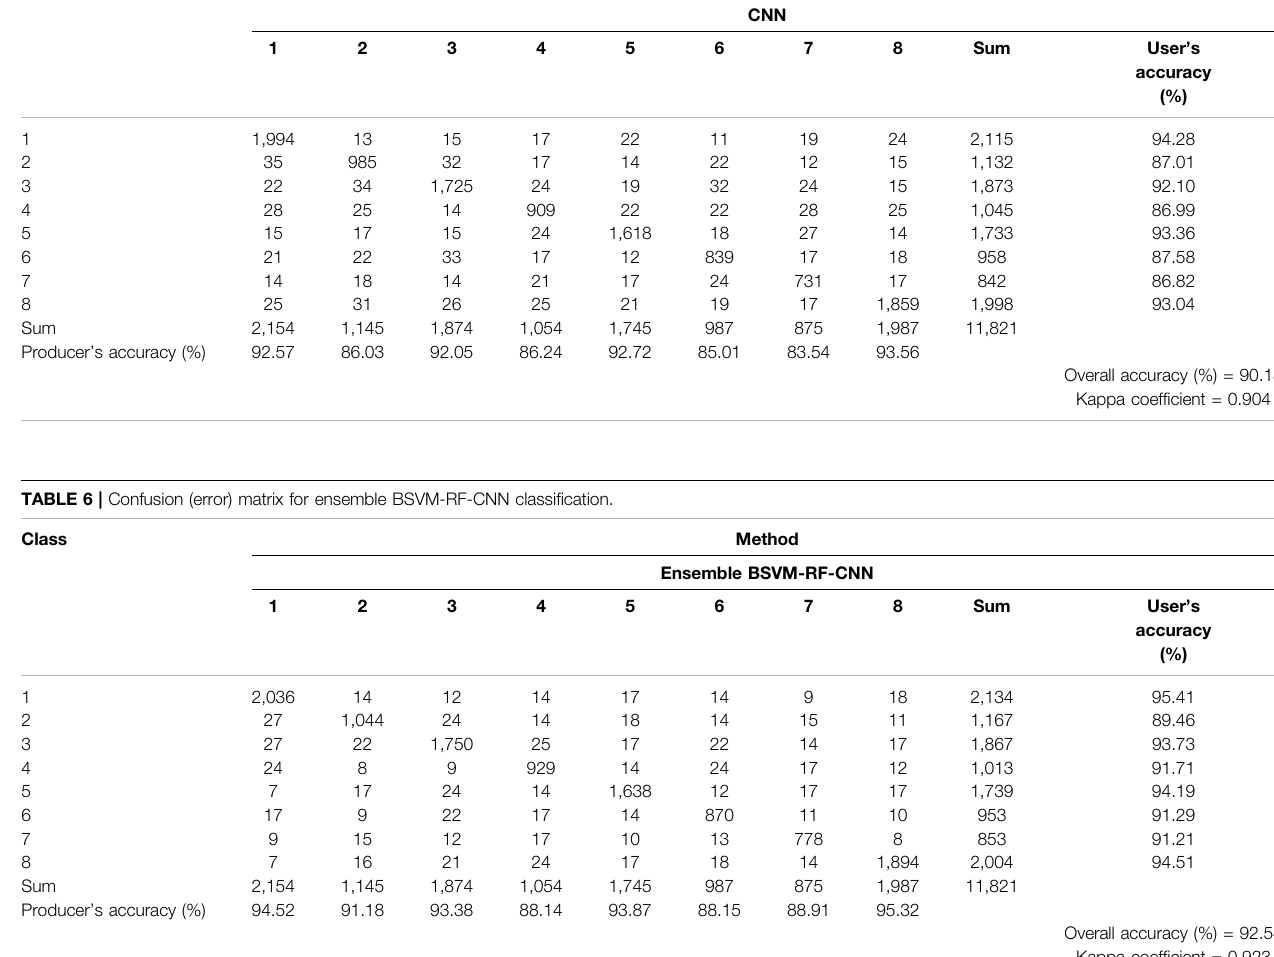
TABLE 5 | Confusion (error) matrix for convolution neural network (CNN) classi fi cation. Class Method